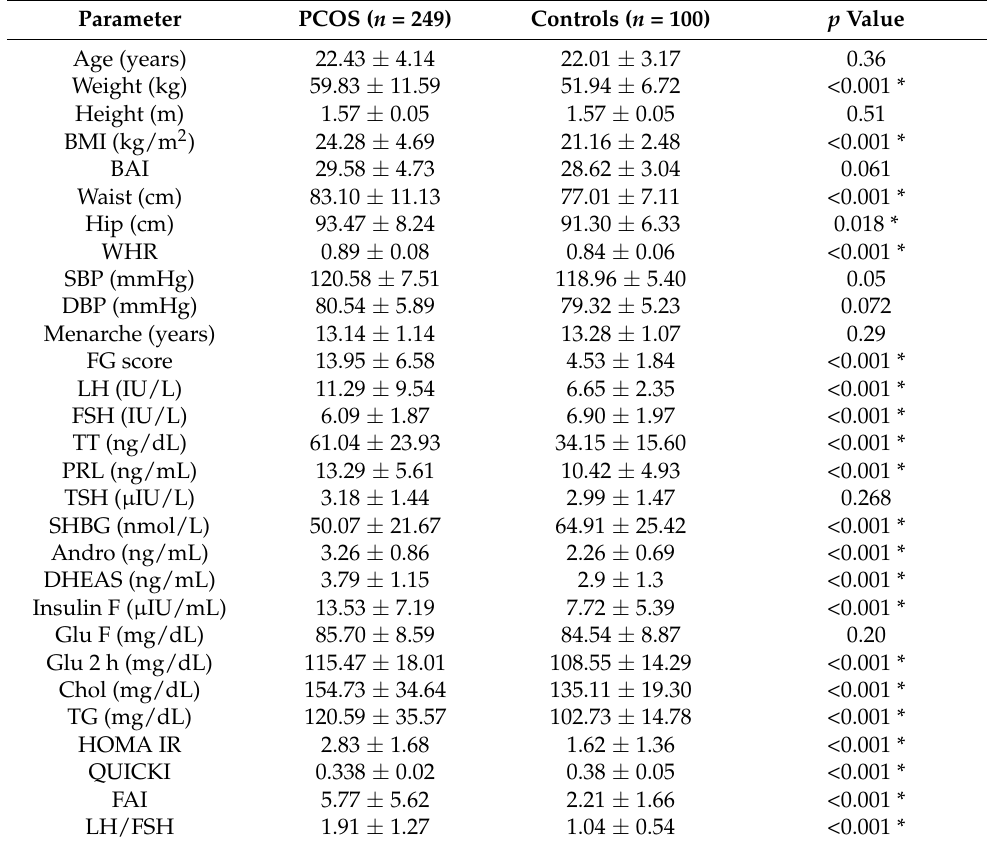
Table 3. Comparison of anthropometric, hormonal, metabolic and biochemical parameters in PCOS cases and healthy